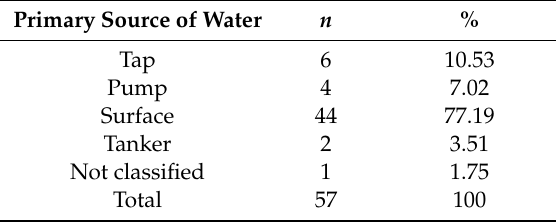
Table 2. Primary sources of water in the Madeya